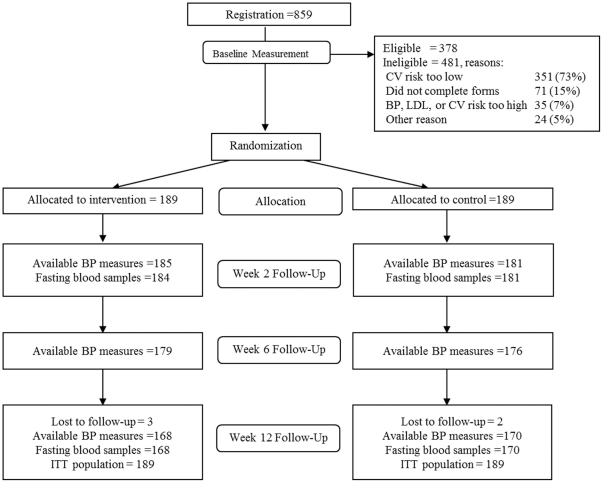
CONSORT flow chart.This figure shows the flow of patients through the trial according to the
criteria recommended in the CONSORT Guidelines.